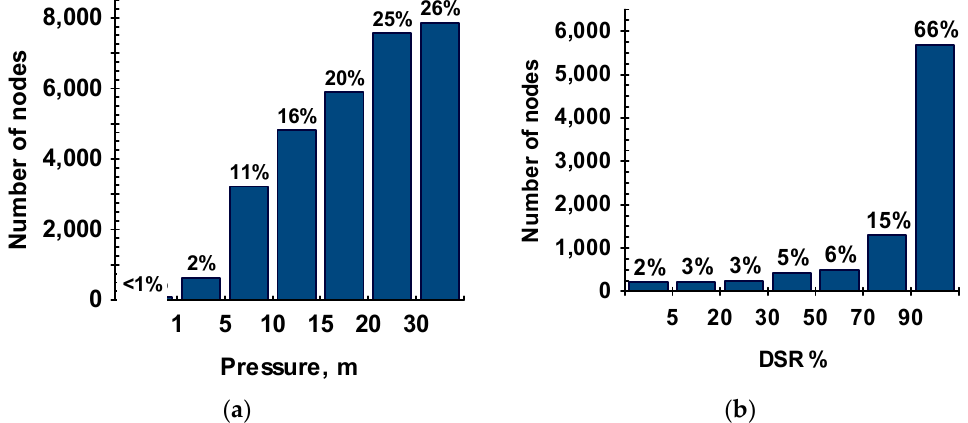
Figure 2. Distribution of: ( a ) nodal pressures for the whole network (30,077 nodes); and ( b ) demand satisfaction ratios (DSRs) for nodes under pressure-deficient conditions (8578 nodes), excluding the nodes with zero